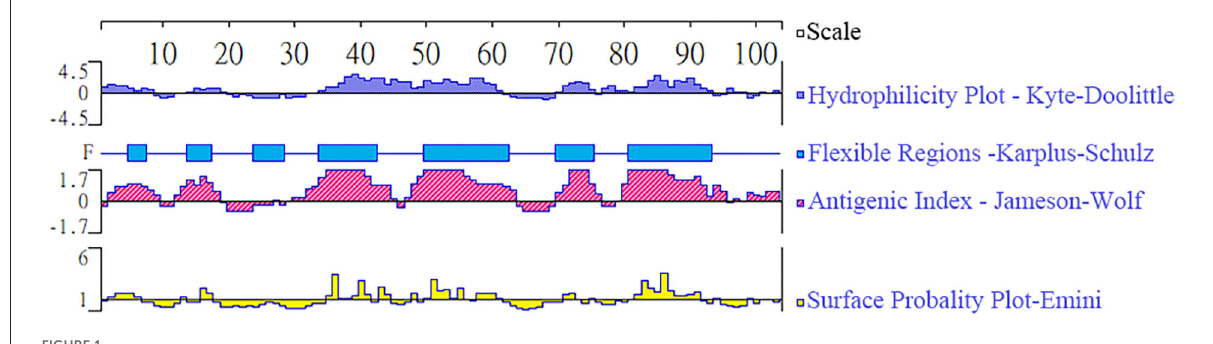
FIGURE1 Epitope analysis of TgBFD1. The linear-B cell epitopes of the TgBFD1 feature key domain were analyzed by DNAstar software, such as hydrophilicity plot, flexible regions, antigenic index, and surface probability.